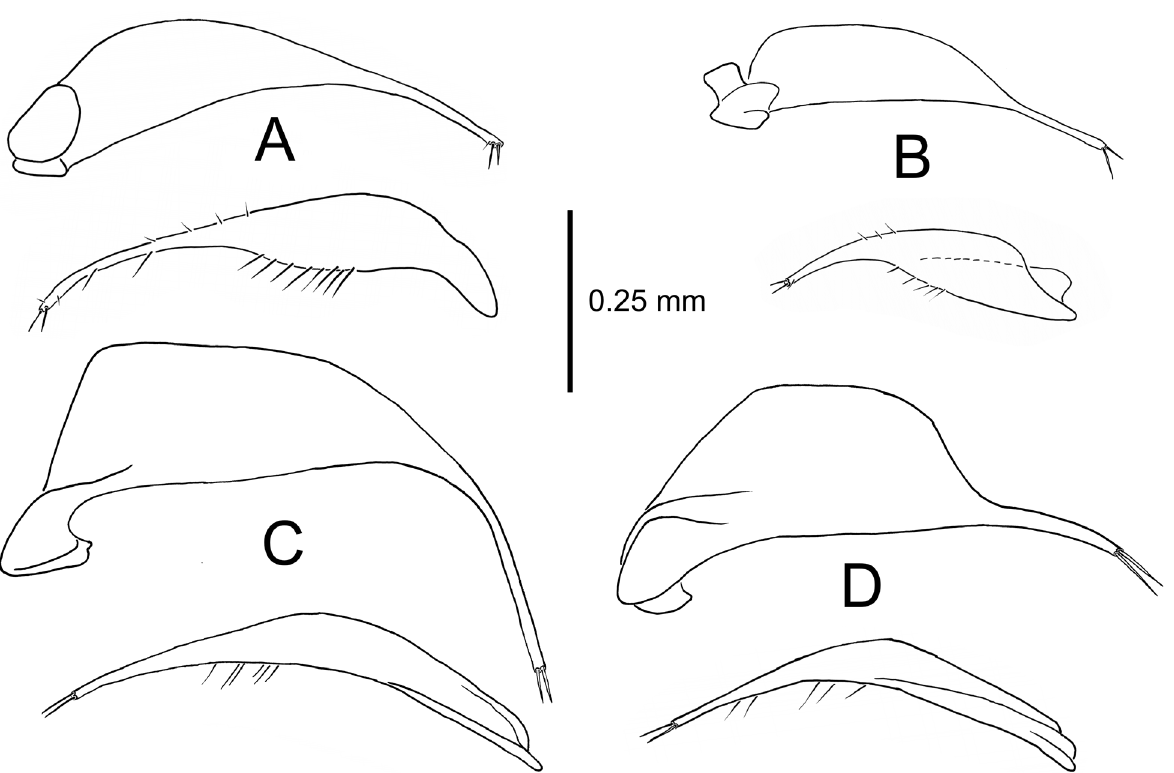
Figure 11. Paired left (above) and right (below) parameres of Mecyclothorax ( Phacothorax ) spp. (ectal view): A , M. laterosinuatus ; B , M. laterorectus ; C , M. fleutiauxi ; D , M.